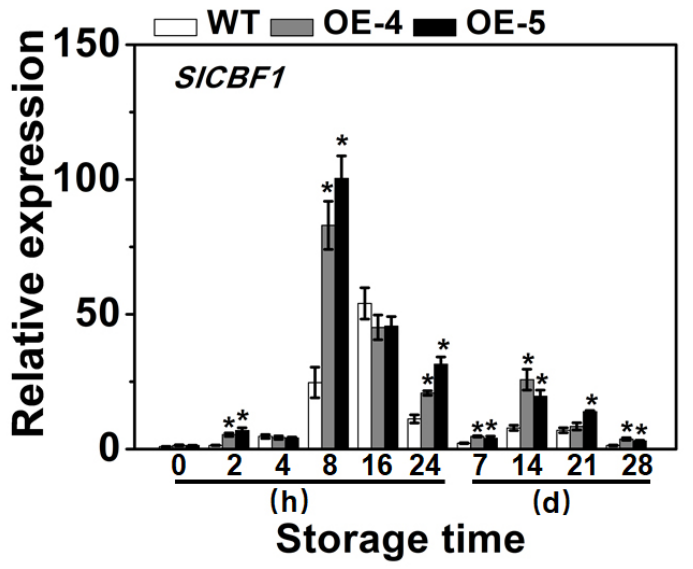
Figure 5. SlCYP90B3 overexpression induced the expression of SlCBF1 in tomato fruits during 28 days of cold storage. Each data point is means ± SE ( n = 3).